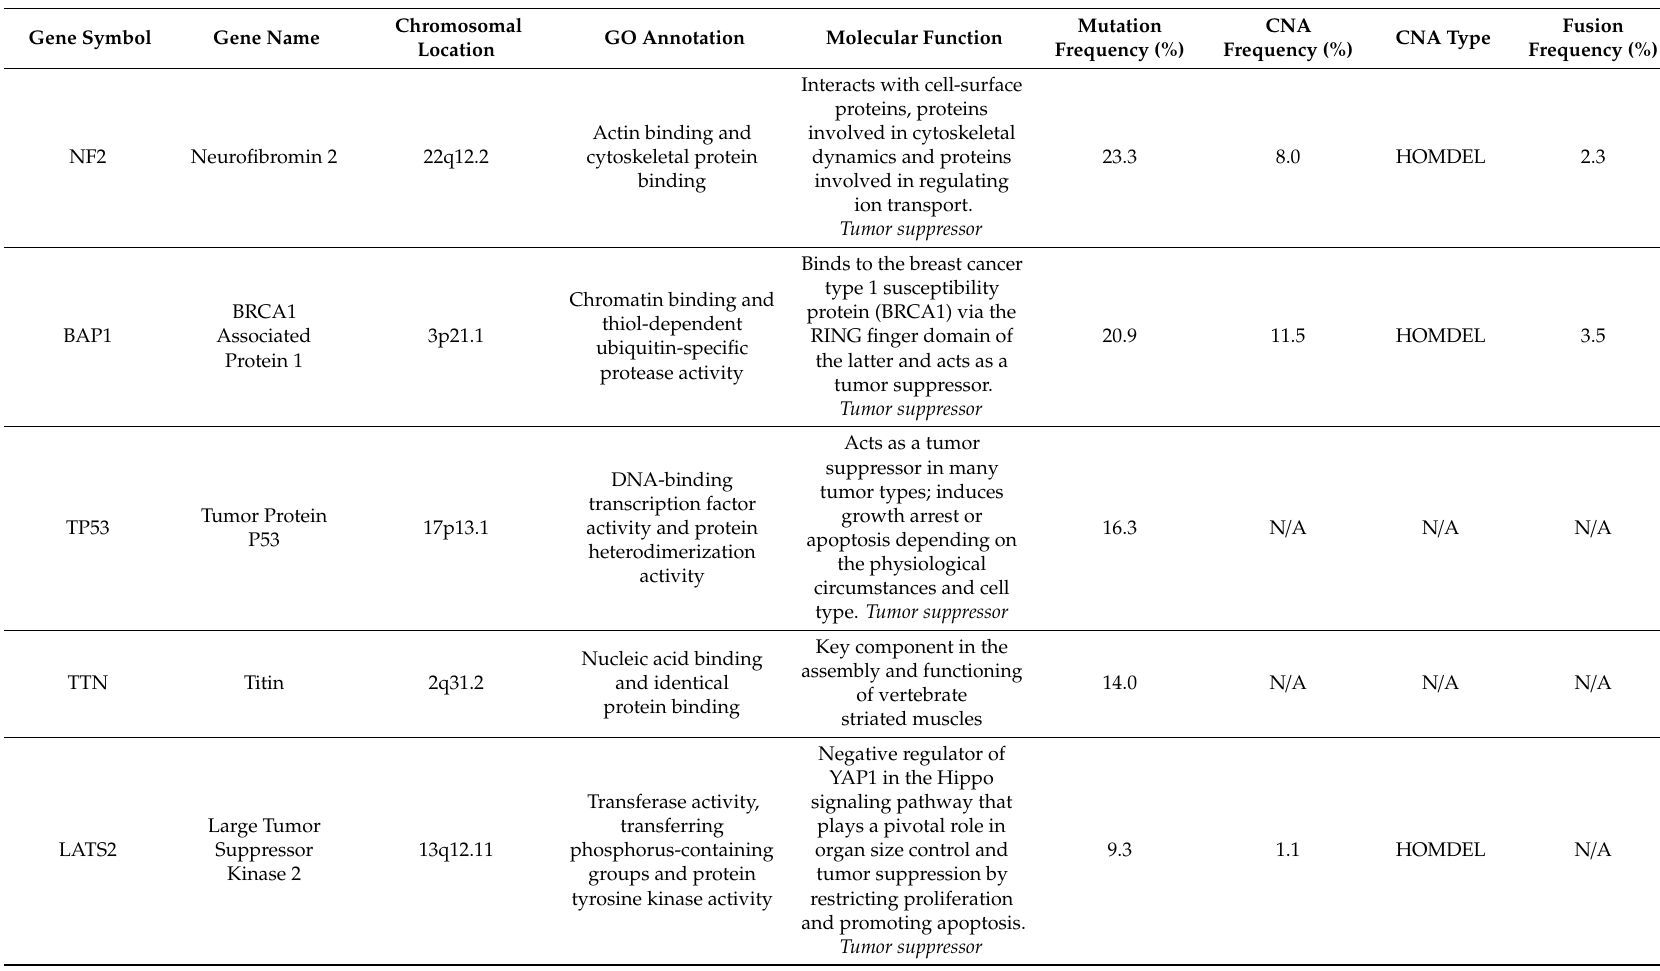
Table 1. Genomic analysis of the TCGA malignant pleural mesothelioma (MPM) cohort using the cBioPortal Resource. N / A: data not